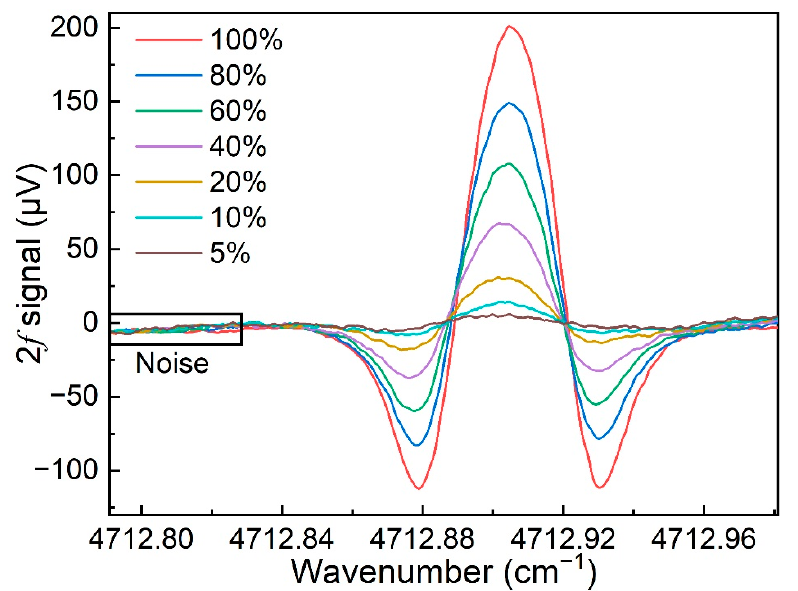
Figure 5. The 2 f signal for TDLAS sensor with different concentrations of H 2 for H 2 -TDLAS sensing system.